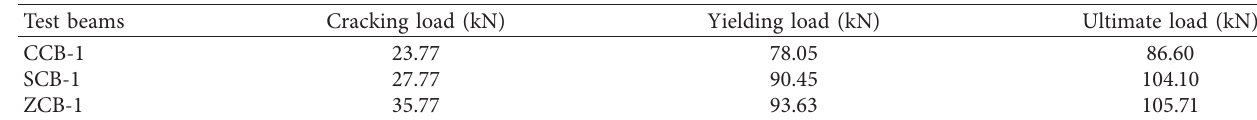
Figure 15: Load-displacement curves of the single-span composite T-shaped beams. Table 7: Cracking load, yielding load, and ultimate load of test